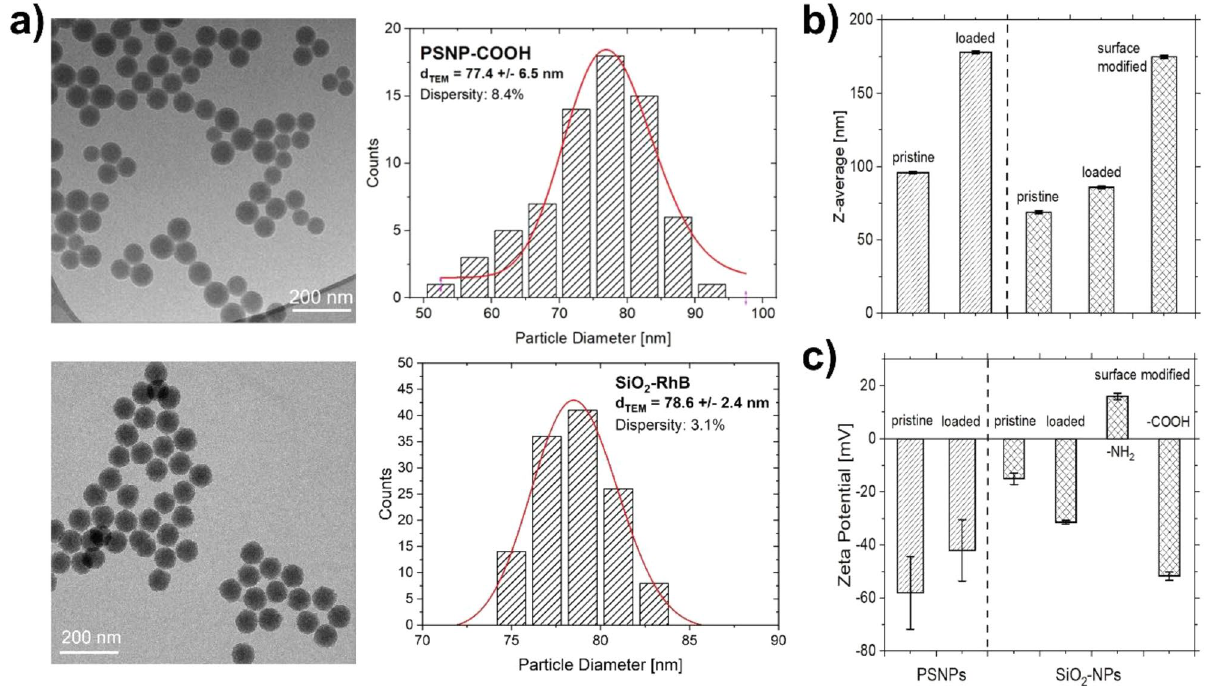
Figure 4. ( a ) TEM images and histograms of the pristine PSNPs and the surface modified SiO 2 -NPs; ( b ) hydrodynamic diameters (z-average) measured by DLS; ( c ) zeta potential measurements after different synthesis